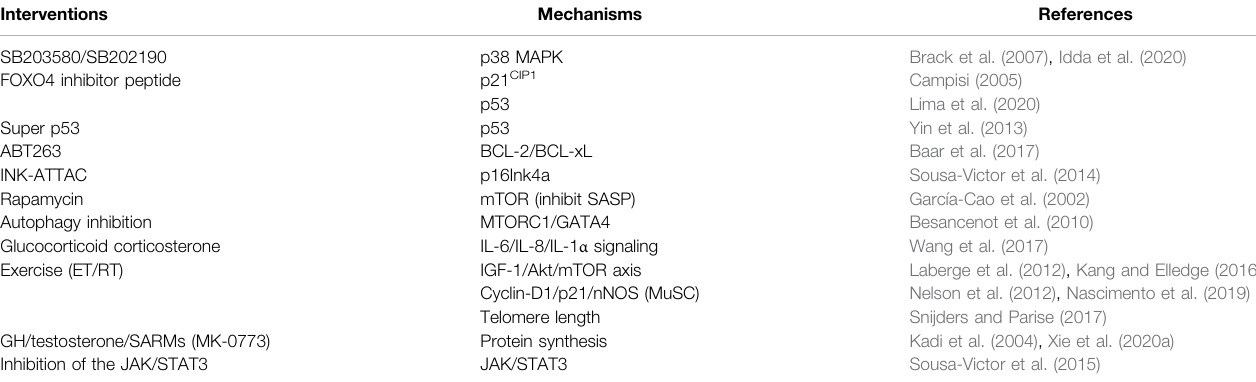
TABLE 1 | Therapeutic interventions based on speci fi c molecules on the signaling pathway of cellular senescence accounting for sarcopenia. Interventions